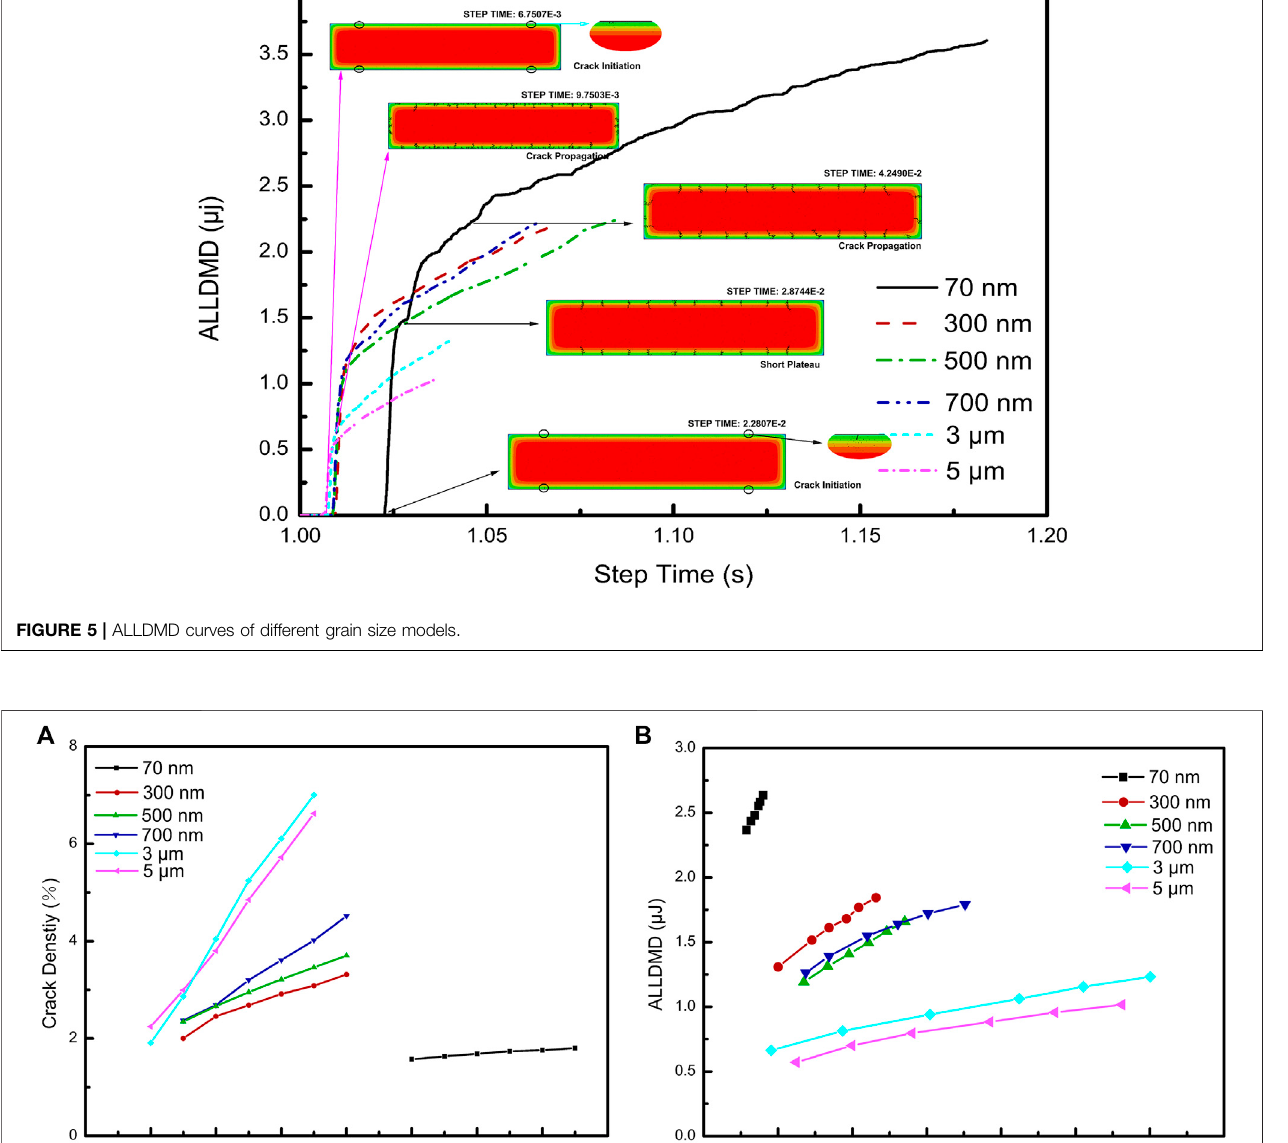
Frontiers in Materials |